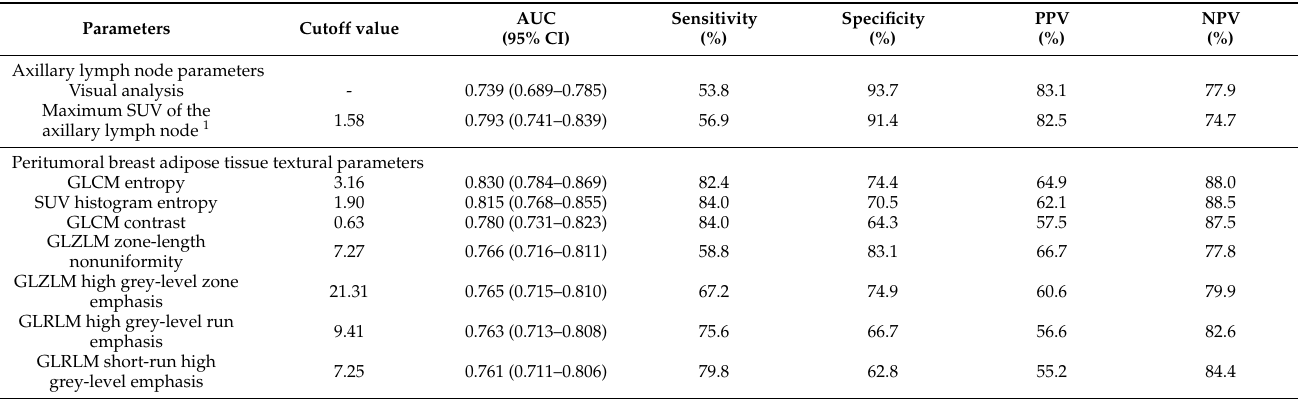
Table 2. Diagnostic ability of the visual analysis and textural features of FDG PET/CT with AUC values > 0.750 for predicting axillary lymph node metastasis.